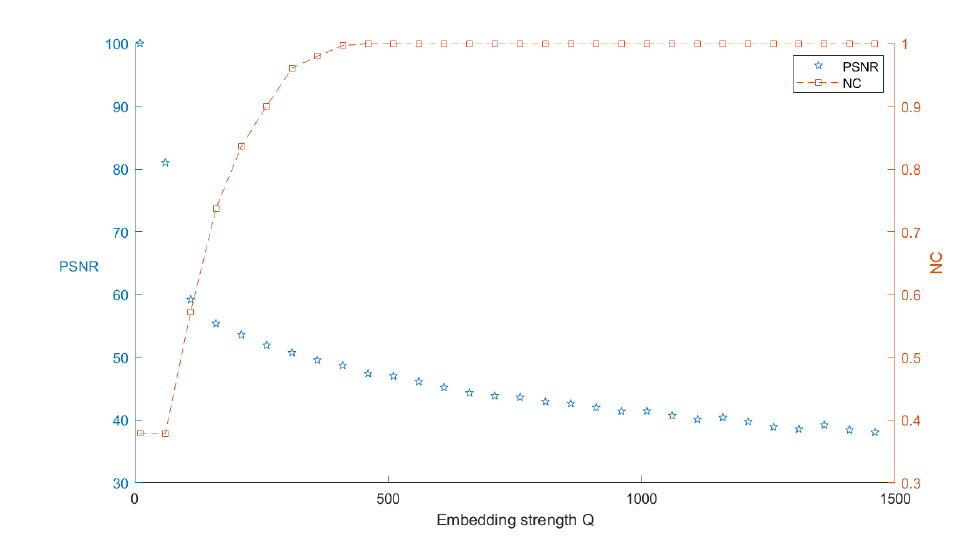
Figure 13. Distribution of PSNR and NC.